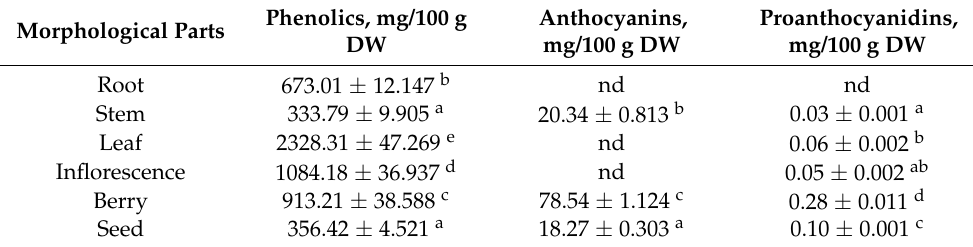
Table 3. The total amount of phenolics, anthocyanins, and proanthocyanidins content of A. cordata morphological